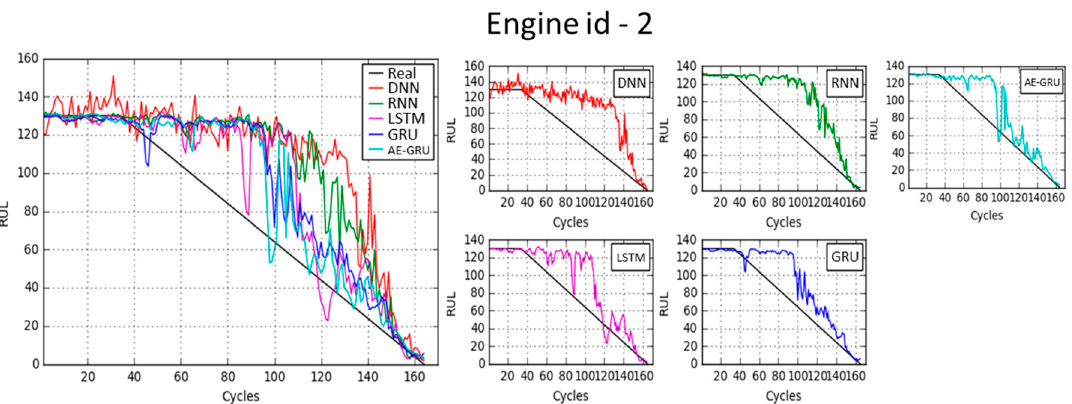
Figure 11. Model testing results comparison (Engine 2).